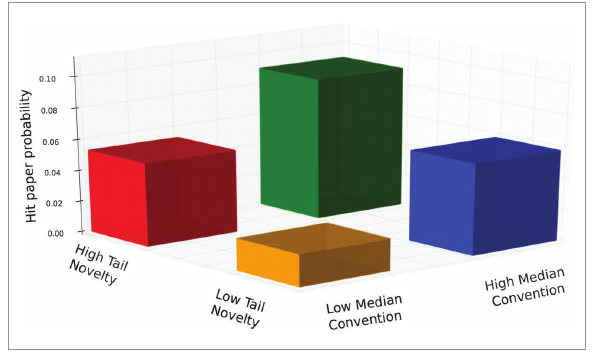
A unique combination of disciplinary depth (conventionality) and novelty significantly increases the impact of research papers.